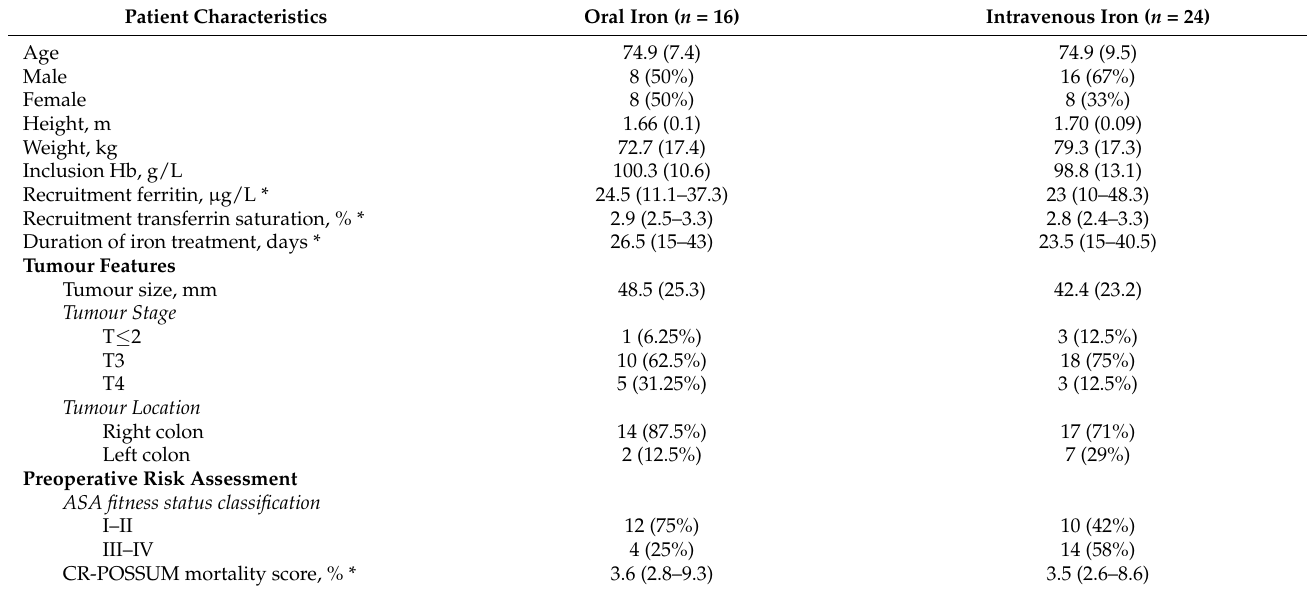
Table 1. Patient cohort demographics. Categorical variables are presented with